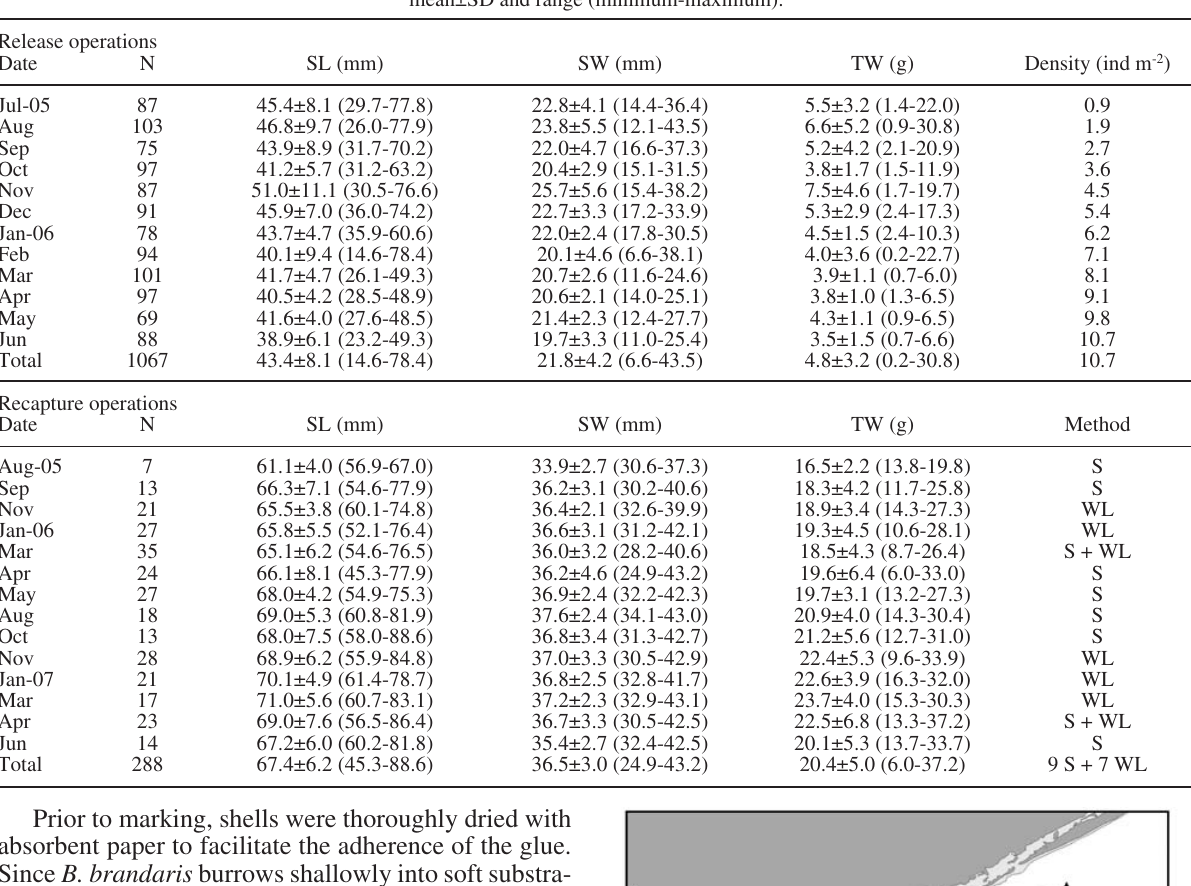
Table 1 . − Data on the release and successful recapture operations of marked Bolinus brandaris , including number (N), shell length (SL), shell width (SW), total weight (TW), stocking density and recapture method (snorkelling - S and/or “wallet-line” - WL). Data presented as mean±SD and range (minimum-maximum).